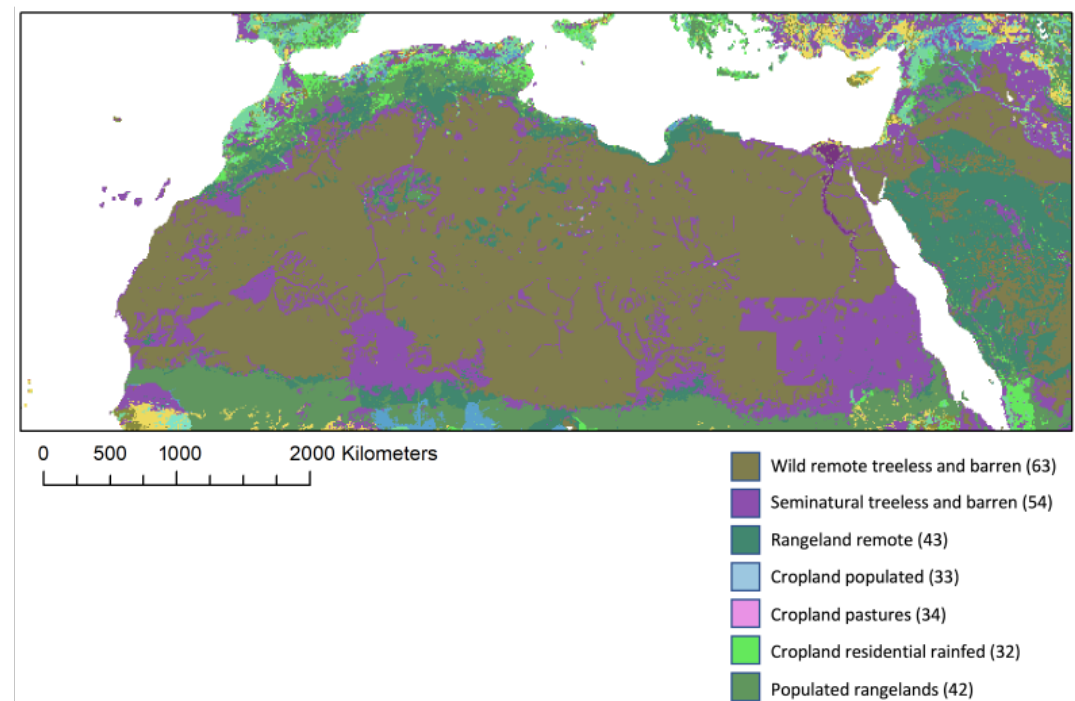
Figure 3. Elaboration from data published by Klein Goldewijk, Dr. ir. C.G.M. (Utrecht University) [33]. Anthropogenic land-use estimates for the Holocene; HYDE 3.2. DANS. Legend displays the original classification of the anthromes (with numbers) as proposed by Ellis and Ramankutty [34]. The legend includes the most represented anthromes as visible in the map (map elaborated with